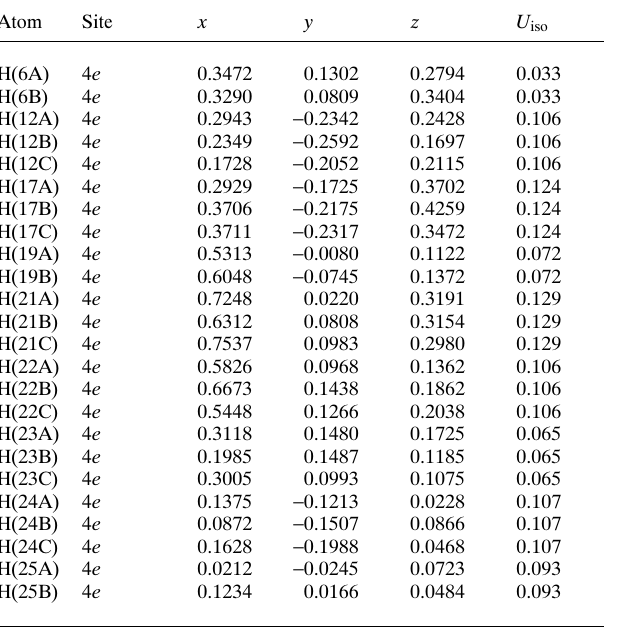
Table 2. Atomic coordinates and displacement parameters (in Å 2 )